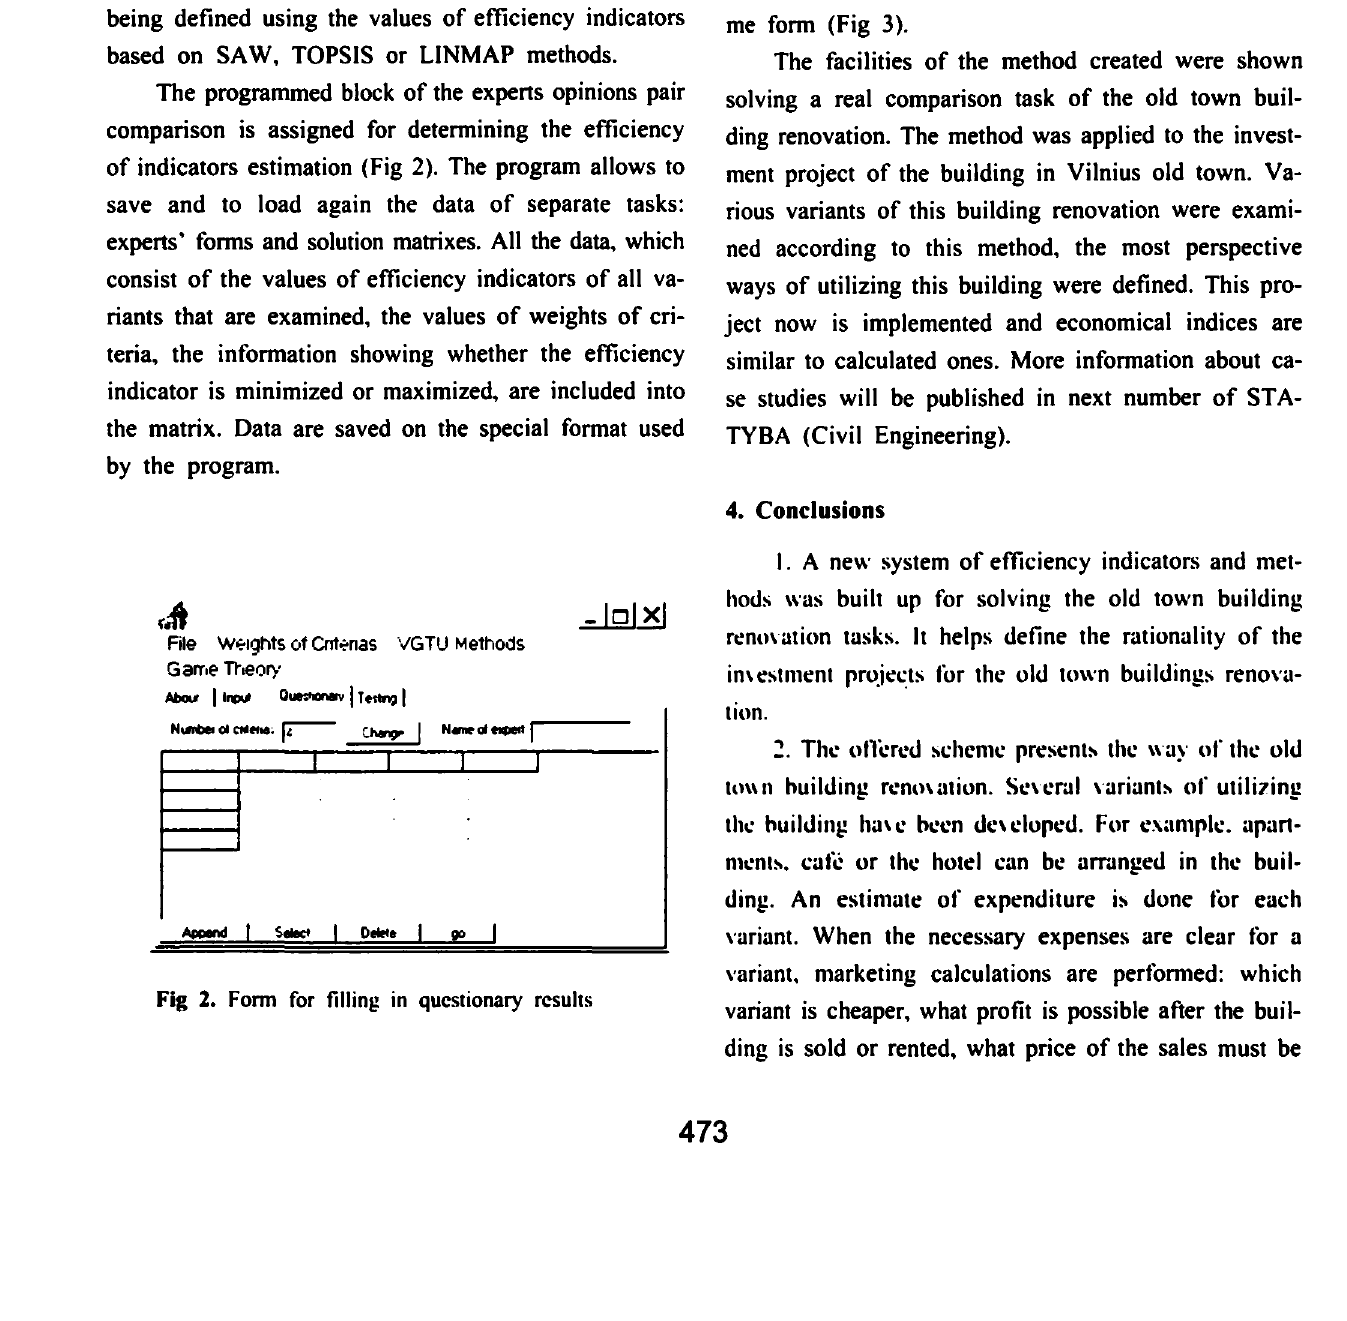
Fig 3. Form for filling in values of